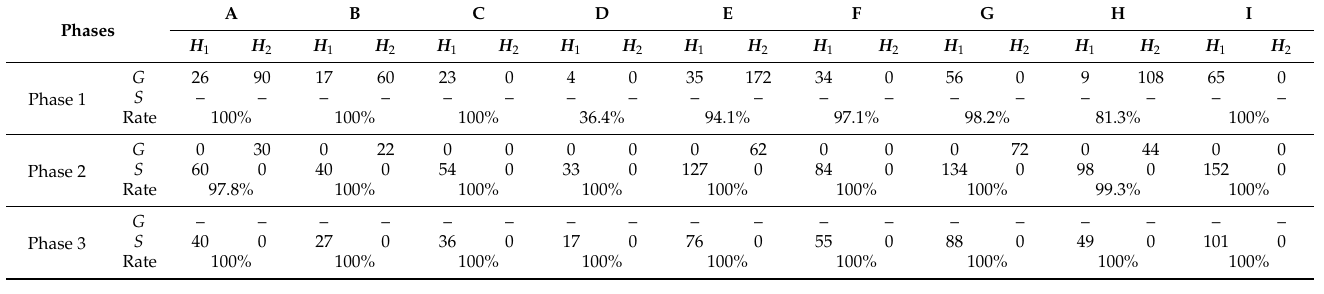
Table 5. Emergency allocation flow under government-enterprise coordination.